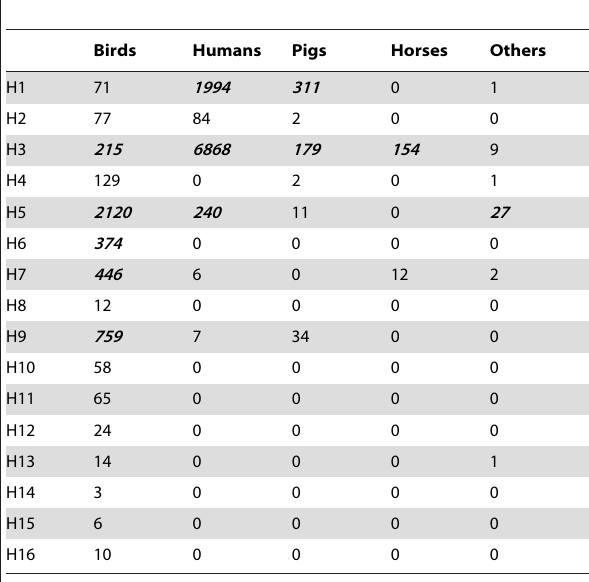
Table 3. Host distribution of 14328 influenza A viruses with HA sequences in